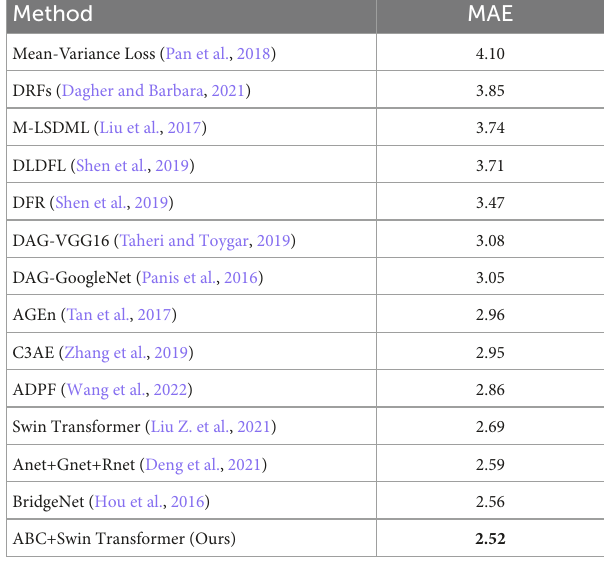
TABLE 1 Comparison of age classification on the MORPH Album II dataset.